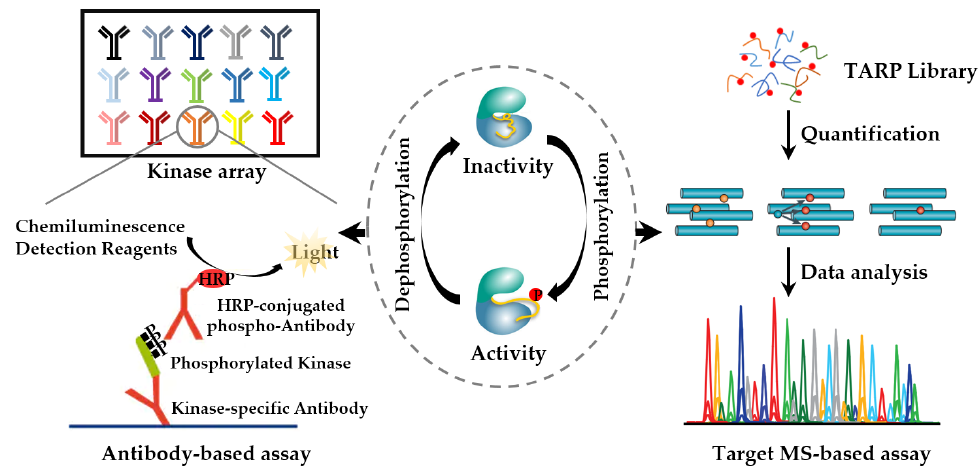
Figure 5. Quantification of kinase activity-representing phosphorylation sites to determine kinome activity. Antibody-based kinase array and target MS-based methods are used for the quantification of phosphorylated kinase.